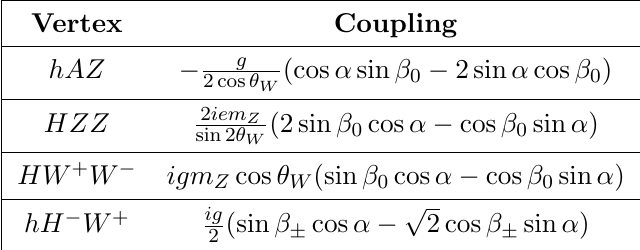
(cid:21) and (cid:21) 2 3